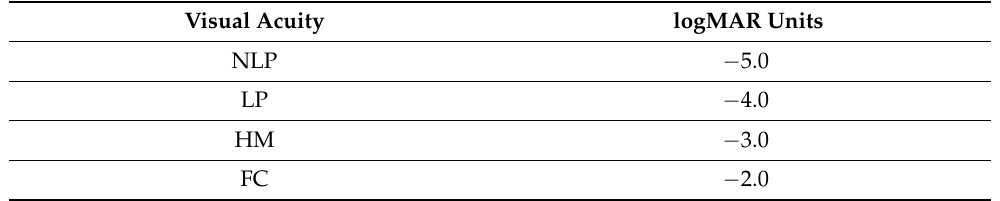
Table 1. Relationship between visual acuity and logarithm of the minimum angle of resolution (logMAR) visual acuity